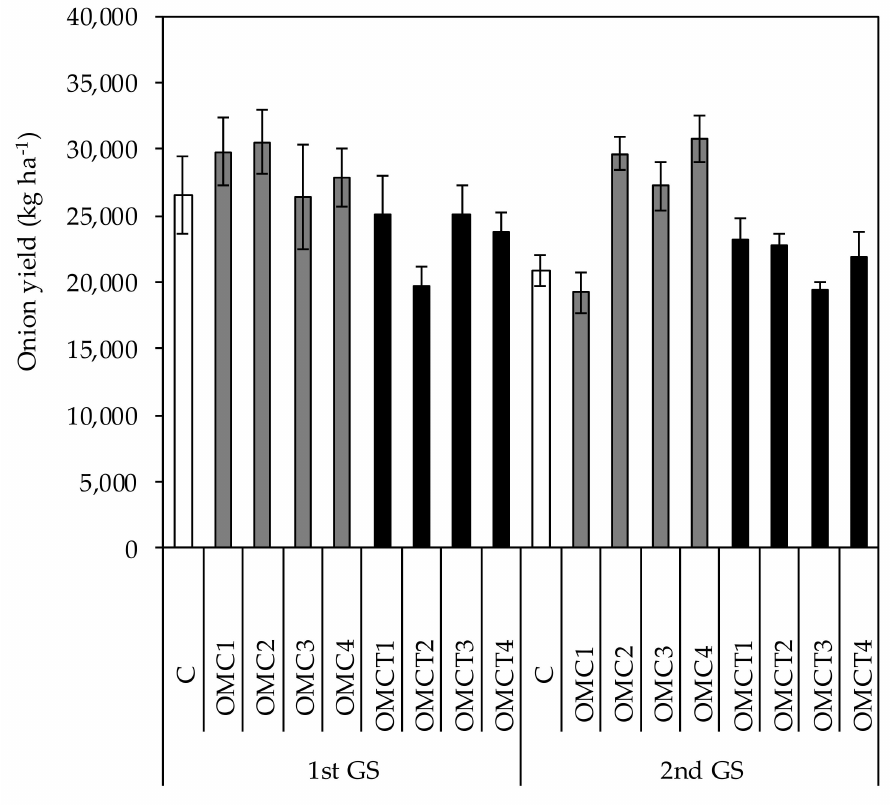
Figure 2. Mean onion yield (kg ha − 1 ) in two consecutive growing seasons. C = control; OMC = onion-manure compost; OMCT = onion-manure compost tea. 1st GS = 2014–2015 growing season; 2nd GS = 2015–2016 growing season. Error bars = standard errors. Table 2. Effect of treatments on some chemical and biological properties of